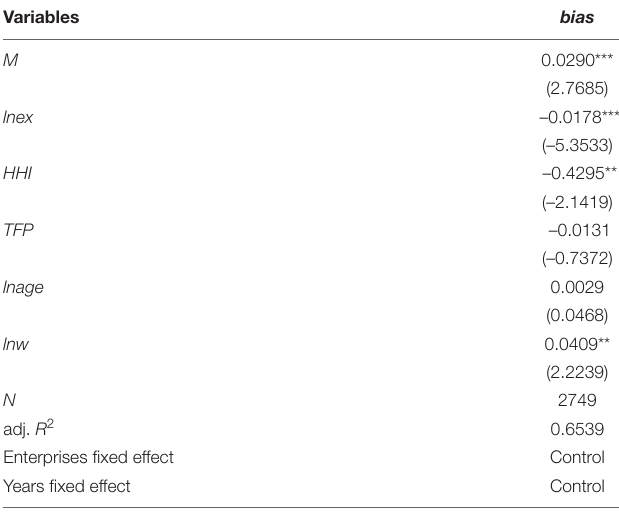
TABLE 4 | Results of principal regression.